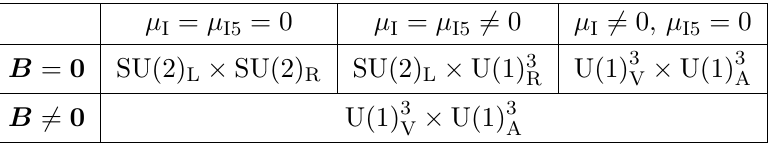
I and (cid:22) I5 in the presence/absence